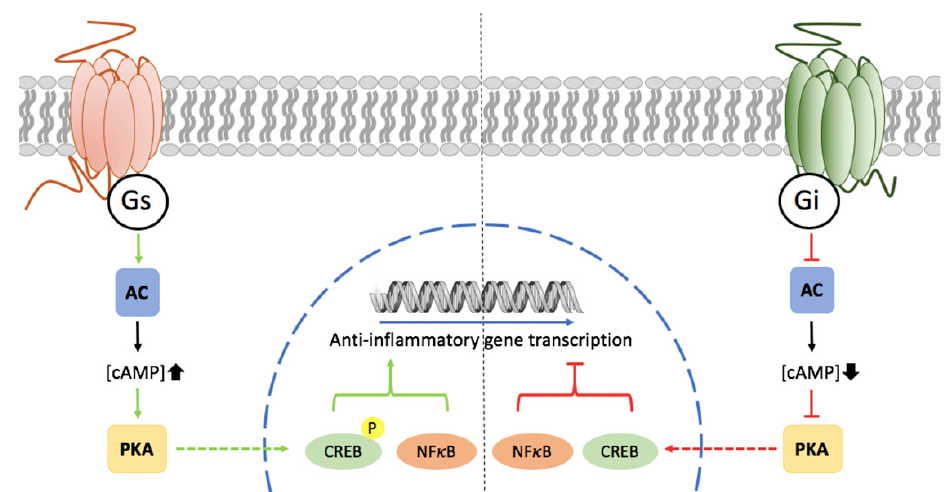
Figure 1. Cell surface GPCRs and the pCREB pathway of transcription regulation of genes producing anti-inflammatory mediators in microglia. Gs-coupled GPCR activation increases cAMP production, activates protein kinase A (PKA), and phosphorylates the cAMP response element-binding (CREB) that induces the transcription of genes related to anti-inflammatory processes. Conversely, Gi-coupled GPCR activation leads to inactivation of the p-CREB pathway. Green color means activation/potentiation and red color means deactivation/blockade.